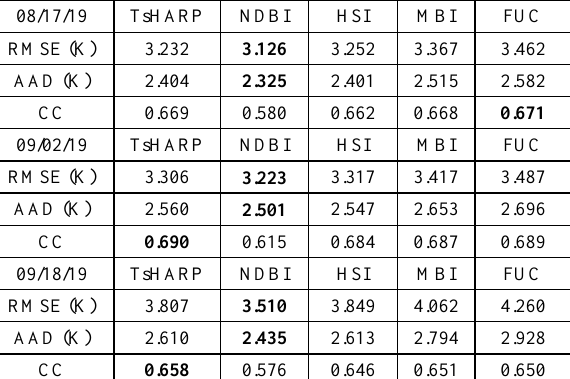
Table 3. Quality assessment results for each